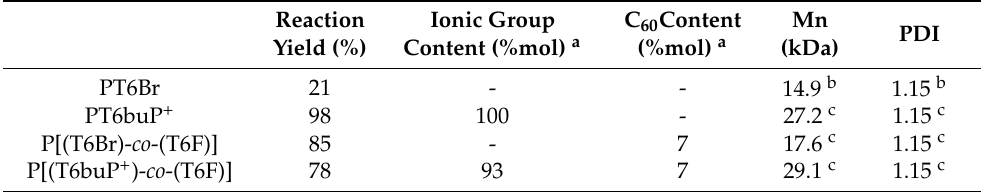
Table 1. Polymers’